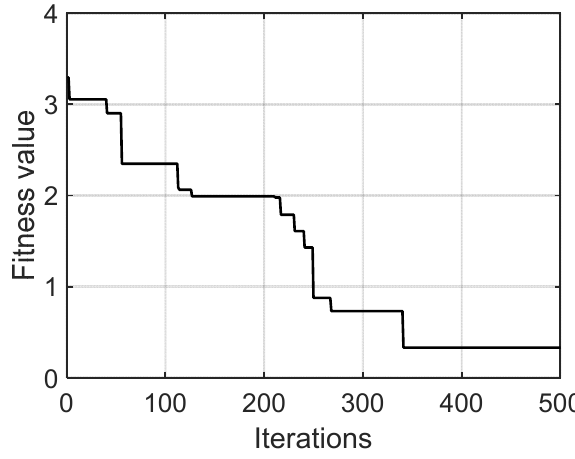
Figure 12. I-PSO-based iteration evolution curve.